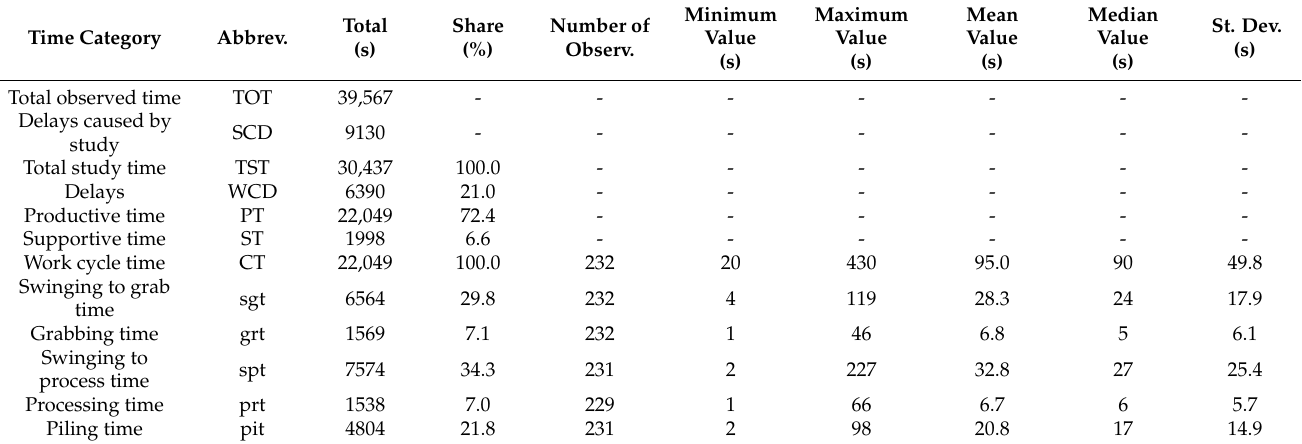
Table 1. Descriptive statistics of the time